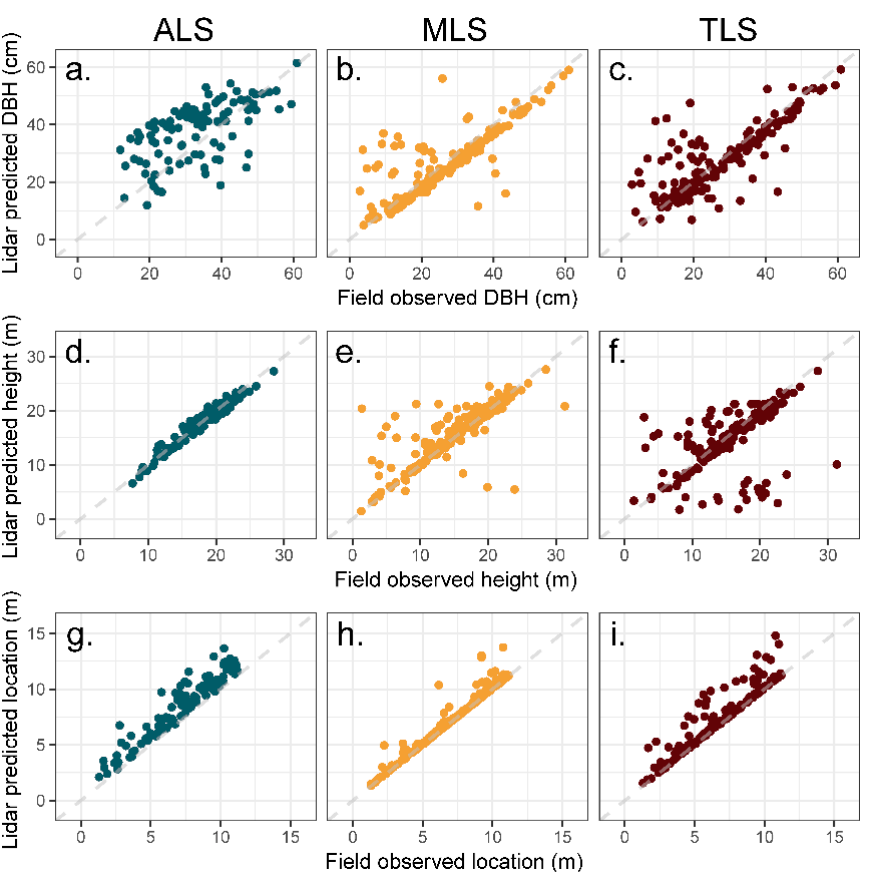
Figure 5. Scatter plots of field observed and lidar-derived ( a – c ) diameter at breast height (DBH, 1.37 m above the ground level), ( d – f ) total tree height, and ( g – i ) absolute difference in tree location for tree’s obtained from airborne (ALS, n = 103), mobile (MLS, n = 200) and terrestrial laser scanning (TLS, n = 159) platforms for ponderosa pine forest in northern Arizona, USA. Tree location error depicted by distance from plot center, as we expected some increased error with distance from center among the MLS tree segmentations. Offset differences in tree location depicted by distance from 1:1 line.